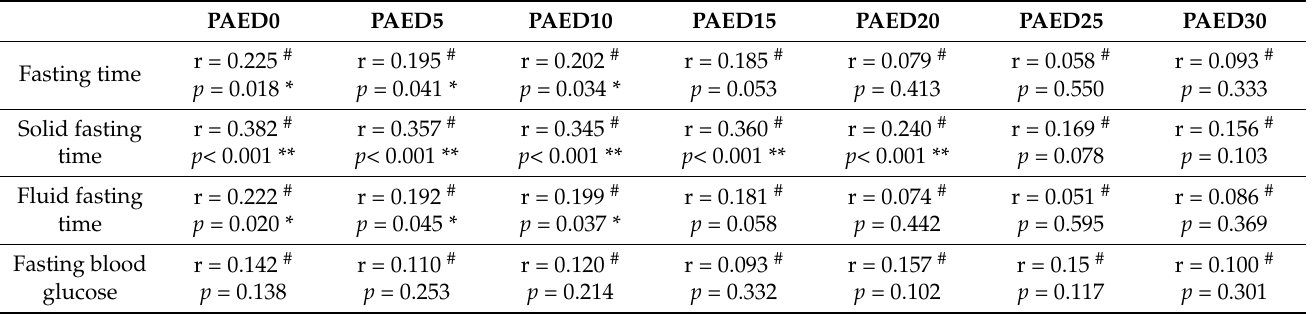
Table 5. Correlation between pediatric anesthesia emergence delirium scores, fasting blood glucose, and fluid and solid food fasting durations at different time